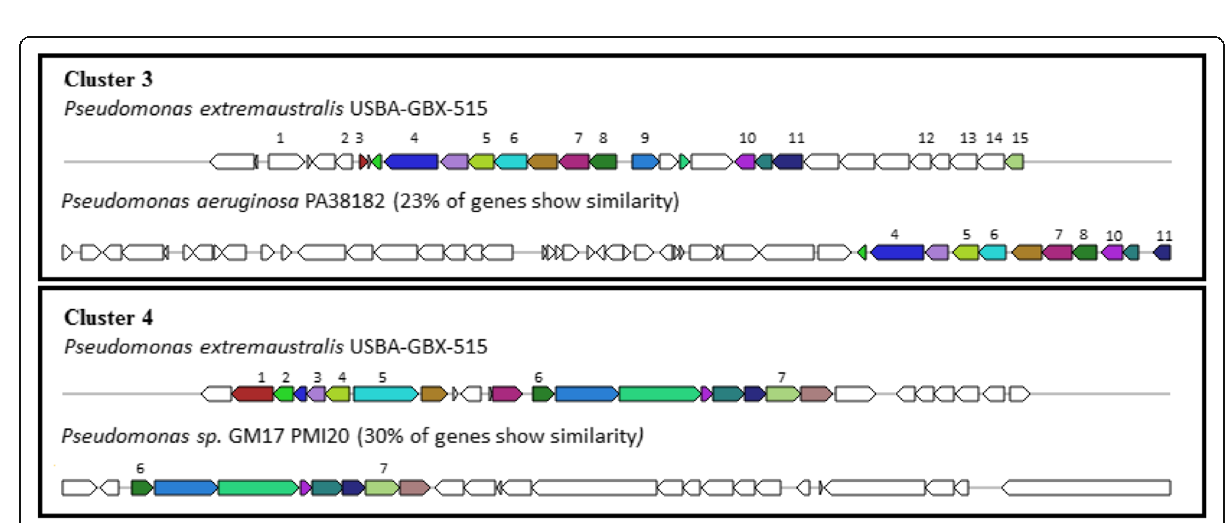
Fig. 7 Genetic map of O-antigen biosynthetic gene cluster 3 and 4 detected by AntiSMASH 3.0. The genes were designated by colors. Same color means equal genes in different strains; not colored means other genes. Cluster 3: 1. Transporter; 2. GntR family transcriptional regulator; 3. TetR family transcriptional regulator; 4. nucleotide sugar epimerase/dehydratase WbpM; 5. NAD-dependent epimerase/dehydratase family protein; 6. glycosyltransferase WbuB; 7. PREDICTED: UDP- glucuronic acid decarboxylase 6; 8. bifunctional UDP GlcNAc C6 dehydratase/C5 epimerase PseB; 9. CPS-53 (KpLE1) prophage; bactoprenol glucosyl transferase; 10. imidazole glycerol phosphate synthase subunit HisF; 11. LPS biosynthesis; 12. 3-oxoacyl-ACP reductase; 13. hypothetical protein; 14. pilin glycosylation protein PglB; 15. mannose-1-phosphate guanyltransferase beta. Cluster 4: 1. two-component sensor; 2. NAD(P)-dependent oxidoreductase; 3. hypothetical protein spr0320; 4. dTDP-D-glucose 4,6-dehydratase; 5. ethanolamine-phosphate phospho-lyase; 6. Epimerase; 7. pellicle/biofilm biosynthesis glycosyltransferase